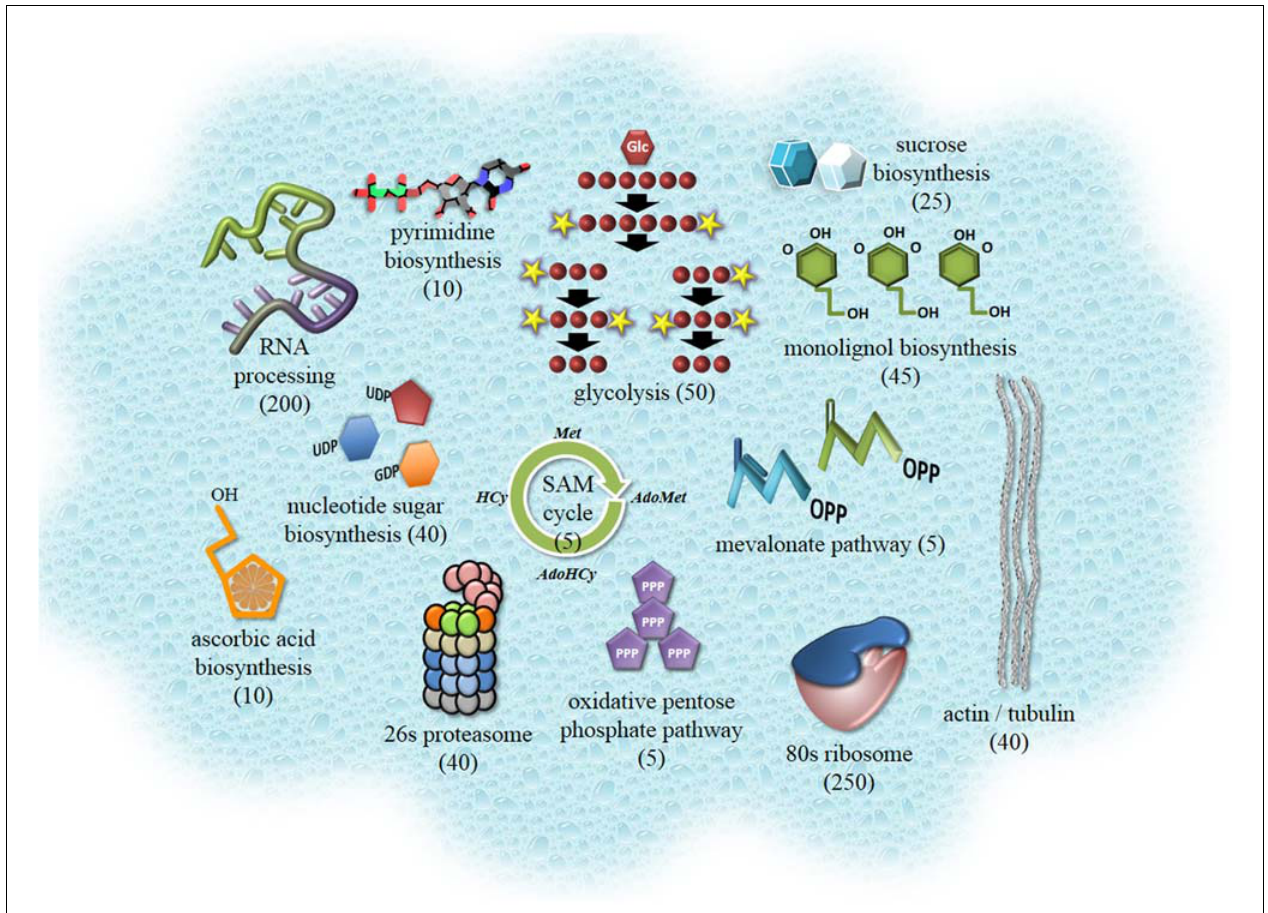
from Plant Metabolic Network resource (Zhang etal., 2005) and from MapMan pathway dataset for Arabidopsis (Thimm etal., 2004). Collectively, over 2,600 proteins can be assigned to the Arabidopsis cytosol when considering proteomics studies, localization with fluorescent proteins and functional